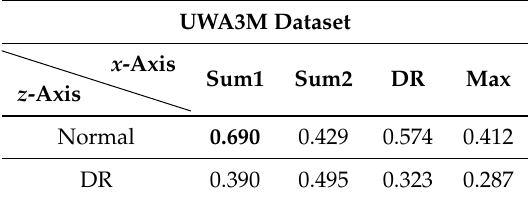
Table 6. MeanCos performance of eight different combinations on UWA3M Dataset.